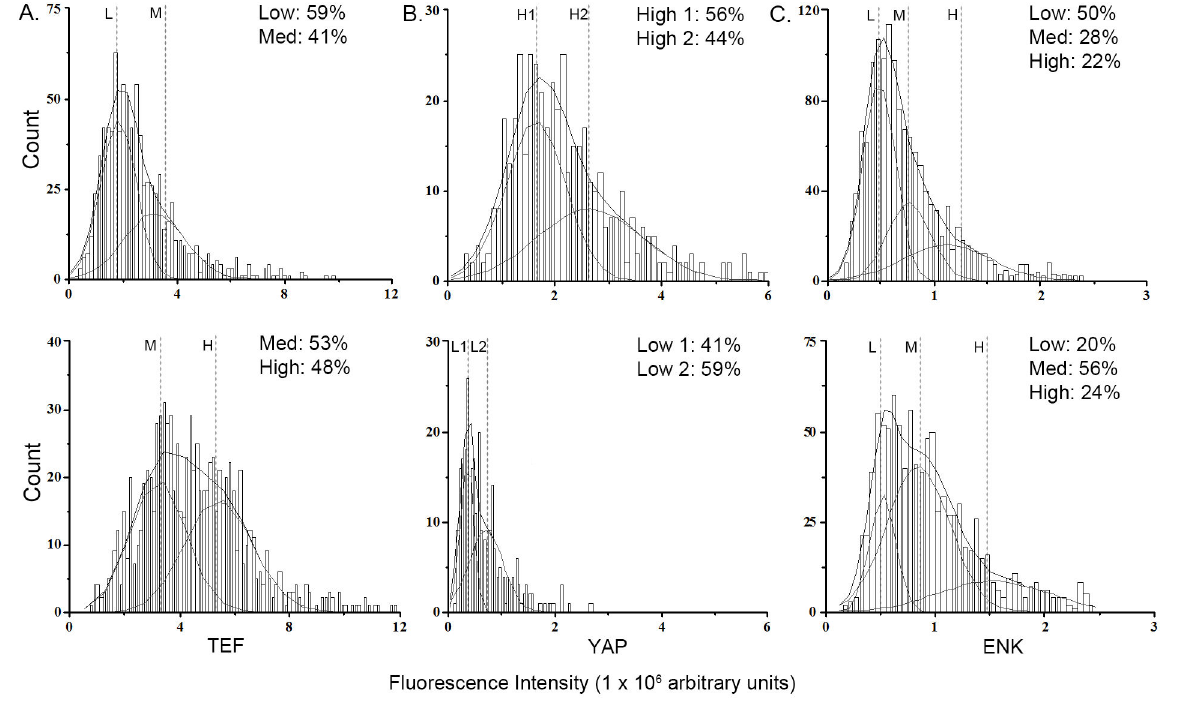
Figure 5. Probability density histogram. The fluorescence intensity for each cell from chow (top) or HFD (bottom) embryos was normalized by subtracting the mean background intensity of a nearby area of comparable size and multiplying the mean intensity within the region by its area, as described in the methods, plotted as a histogram, and fitted to a probability density function. The area under the curve represents the density of cells within each population and is portrayed as a percentage of the total area. (A) Two populations of TEF-expressing neurons were found from chow embryos, arbitrarily assigned as L and M representing low and medium peptide levels, and two were found from HFD embryos, assigned as M and H representing medium and high peptide levels. This shift in fluorescence intensity suggests that HFD increased the levels of TEF in each individual neuron. (B) Two populations of YAP-expressing neurons were found from chow embryos, arbitrarily assigned as H1 and H2 representing high levels of peptides, and two populations were found in neurons from HFD embryos, L1 and L2, representing low levels of peptides. A shift from higher to lower intensity was found in HFD compared with chow embryos, suggesting decreased YAP levels in individual neurons; (C) Three populations of ENK-expressing neurons with the same intensity, L, M and H, were found in both HFD and chow embryos, with a shift in the percentage of neurons exhibiting low intensity to medium and high intensity in the HFD embryos, suggesting increased ENK levels in individual neurons. Goodness of fit was determined based on X 2 values corresponding to p <